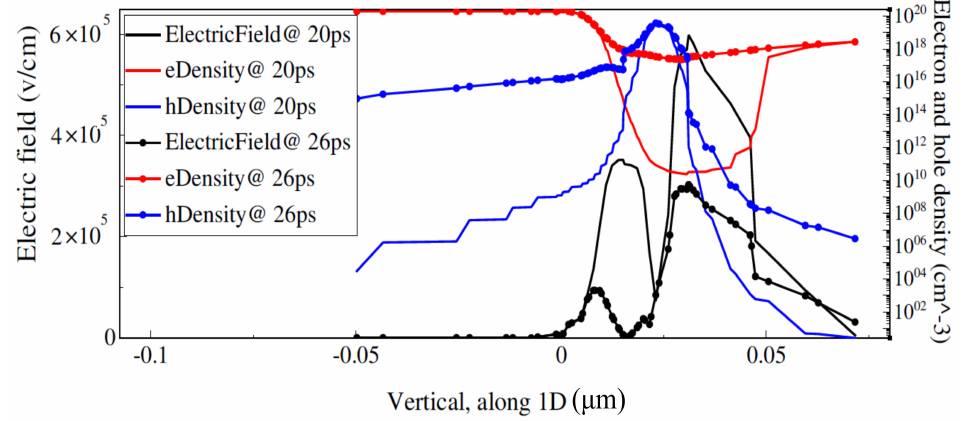
Figure 11. Variation of electric field (left axis) and carrier density (right axis) captured at 20 ps (solid line) and 26 ps (solid line with symbols). The bias voltages V BE = V CE are ramped up from 0 V to 0.9 V at 18 ps with a rise time of 2 ps. The value ‘0’ on the x -axis refers to the position where the poly-emitter and mono-emitter meet.